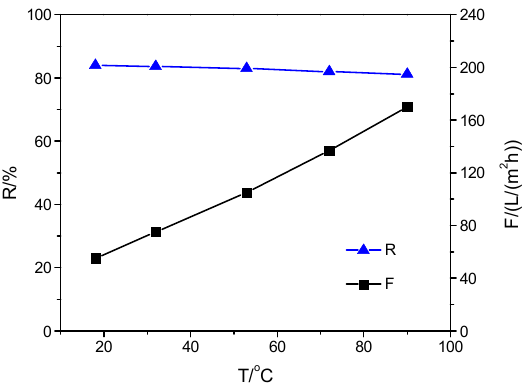
Figure 4. Influence of operating temperature on the properties of SPPHES composite membrane.